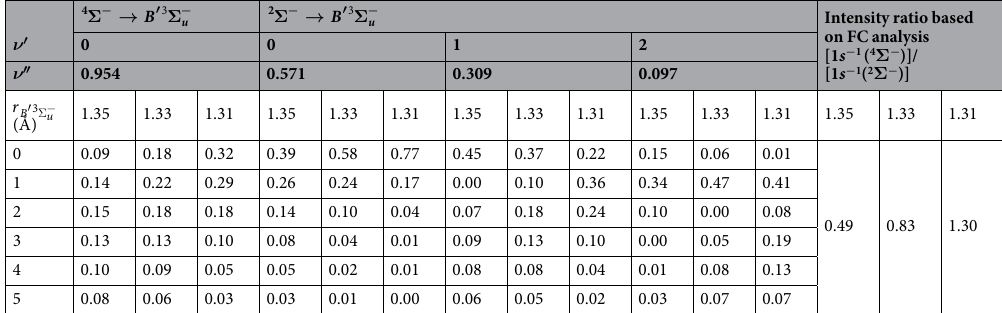
Table 4. The Franck-Condon factors of the decay assuming Morse potentials.